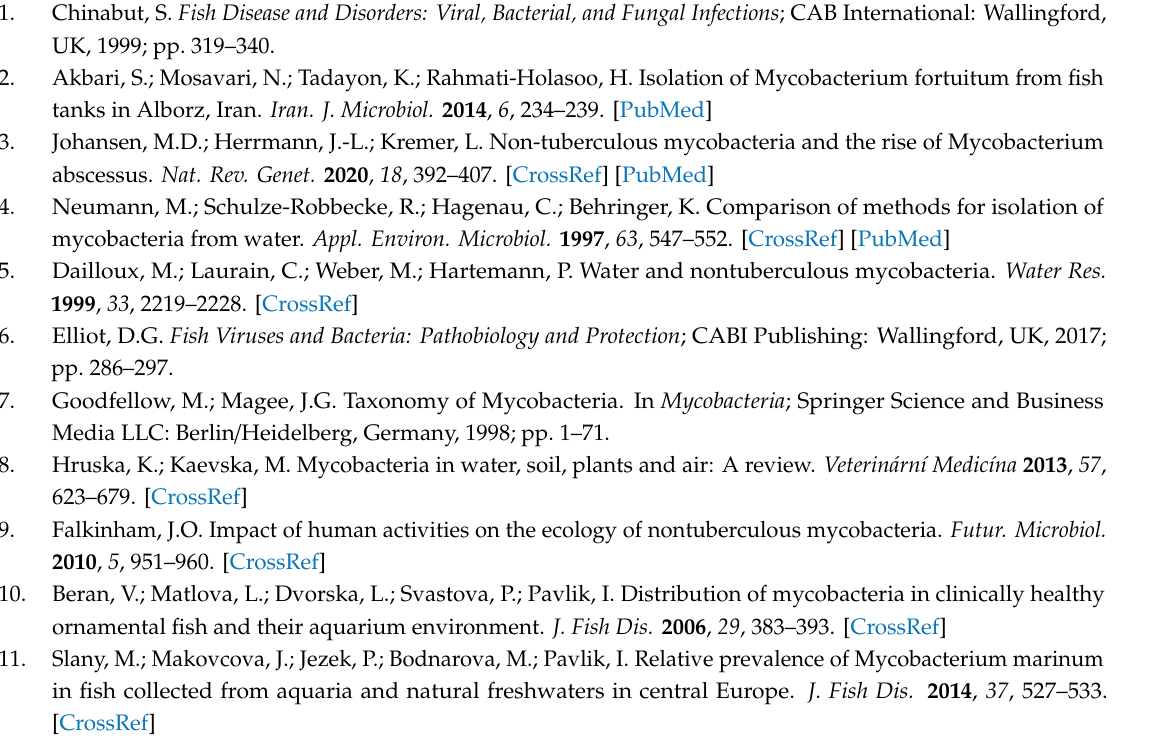
Table S1: Most similar sequences for the amplicons in the database of the National Center for Biotechnology Information, based on the results from a search using the Basic Local Alignment